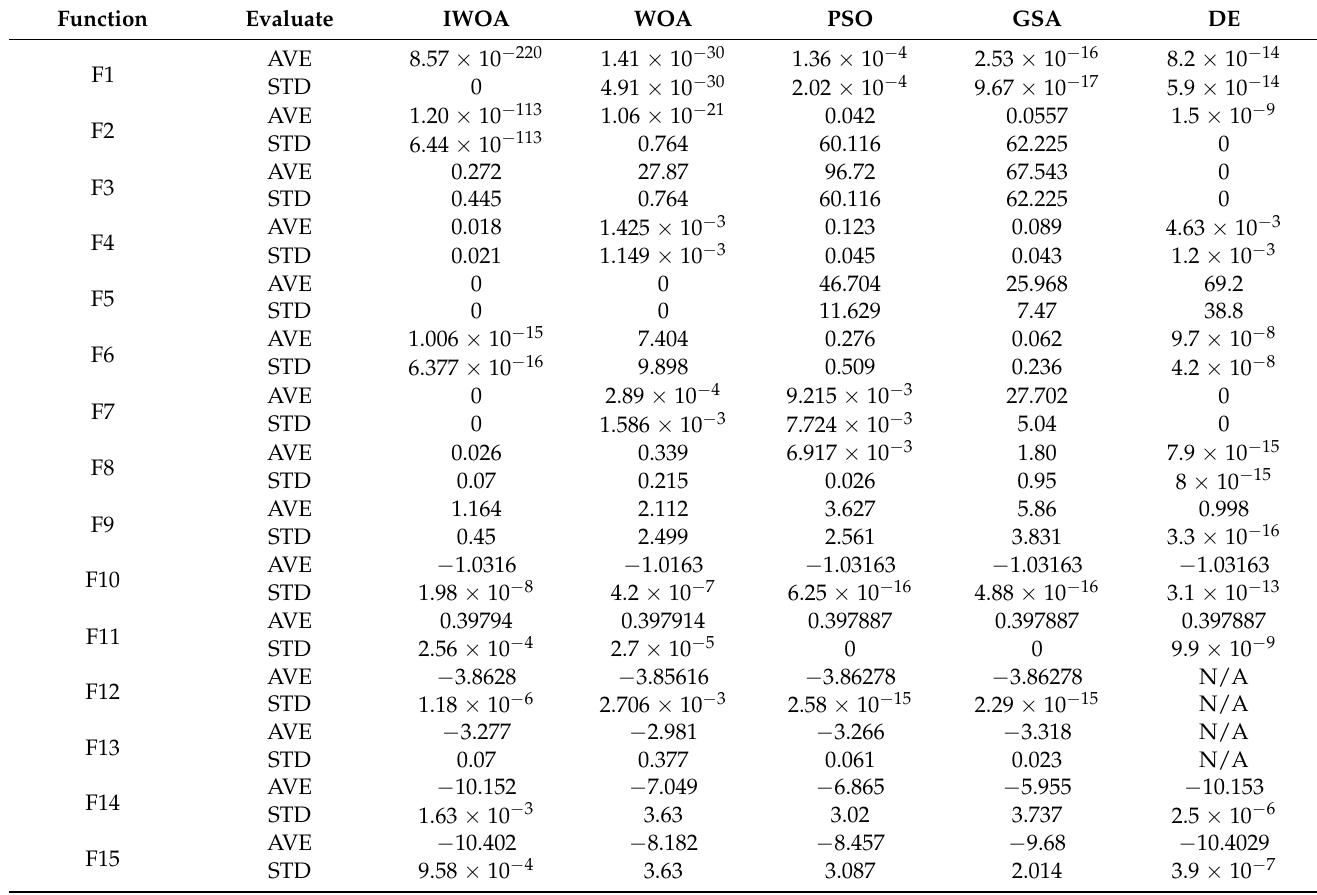
Table 4. Compared with the performance of the classic algorithm.